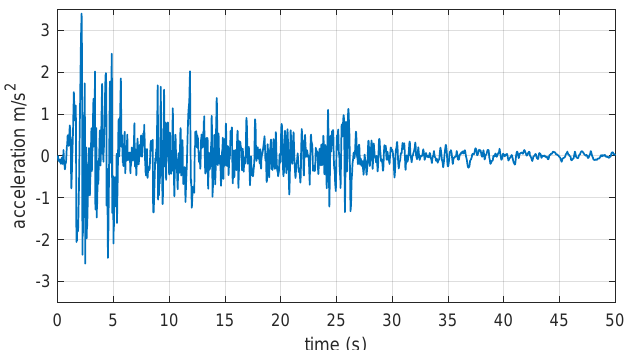
Figure 8. Full-scale 180-component of El Centro 1940 ground-acceleration seismic record with an absolute acceleration-peak of 3.417 m/s 2 . Data available at Strong-Motion Virtual Data Center (VDC) (ftp://